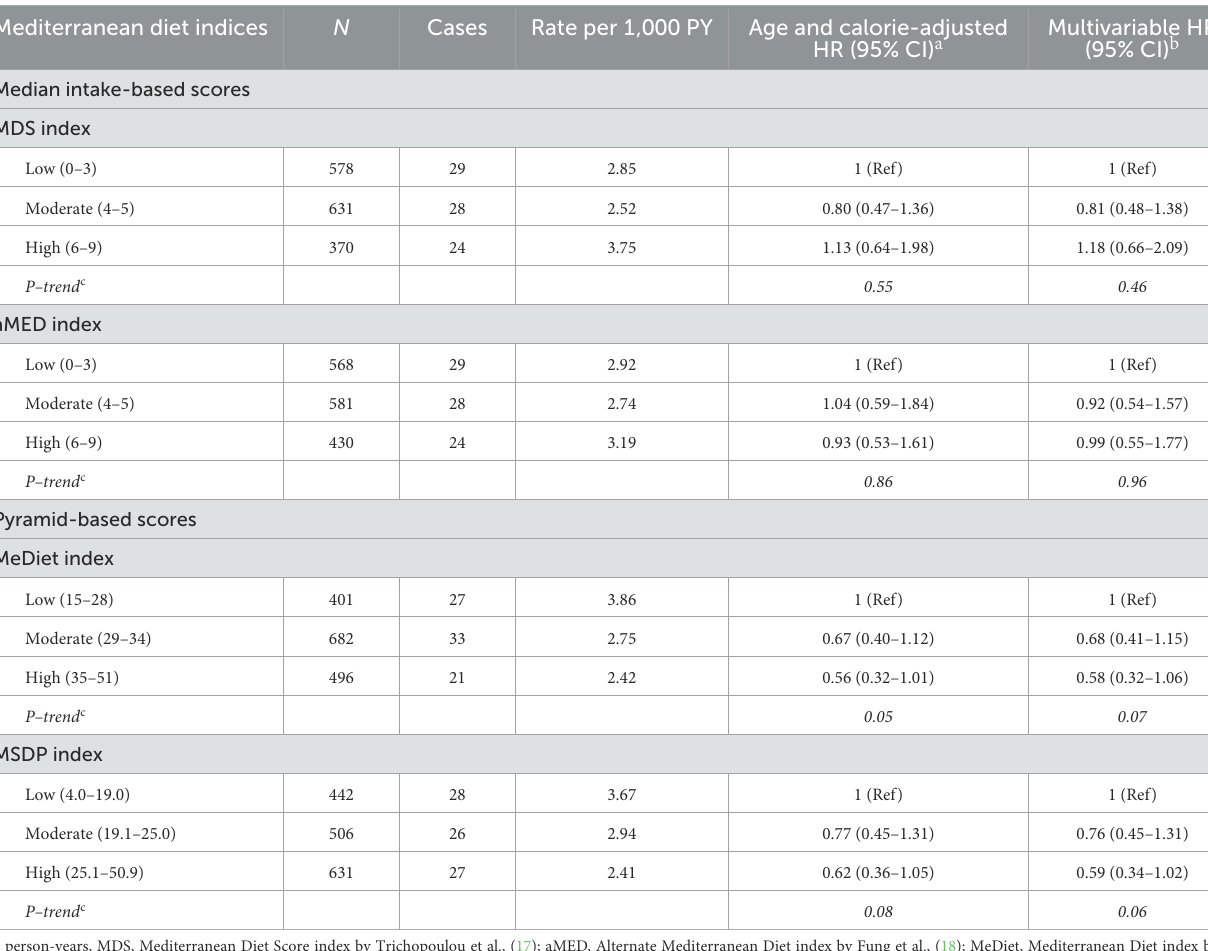
TABLE 4 Hazard ratios for postmenopausal breast cancer associated with Mediterranean diet indices. Mediterranean diet